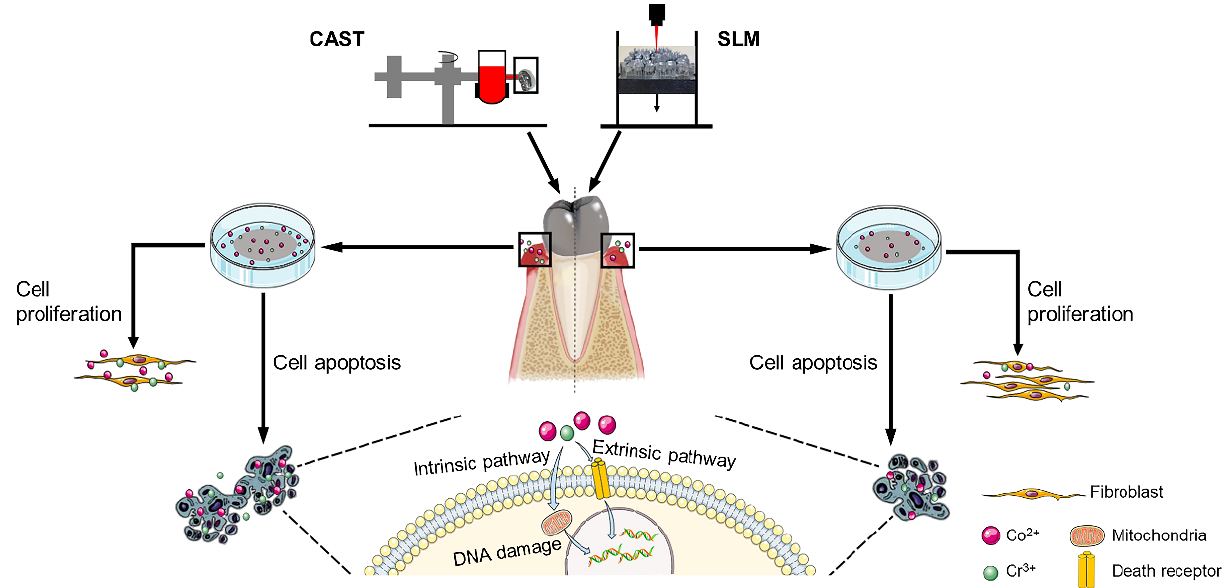
Figure 1. Schematic illustration of the experimental procedure.